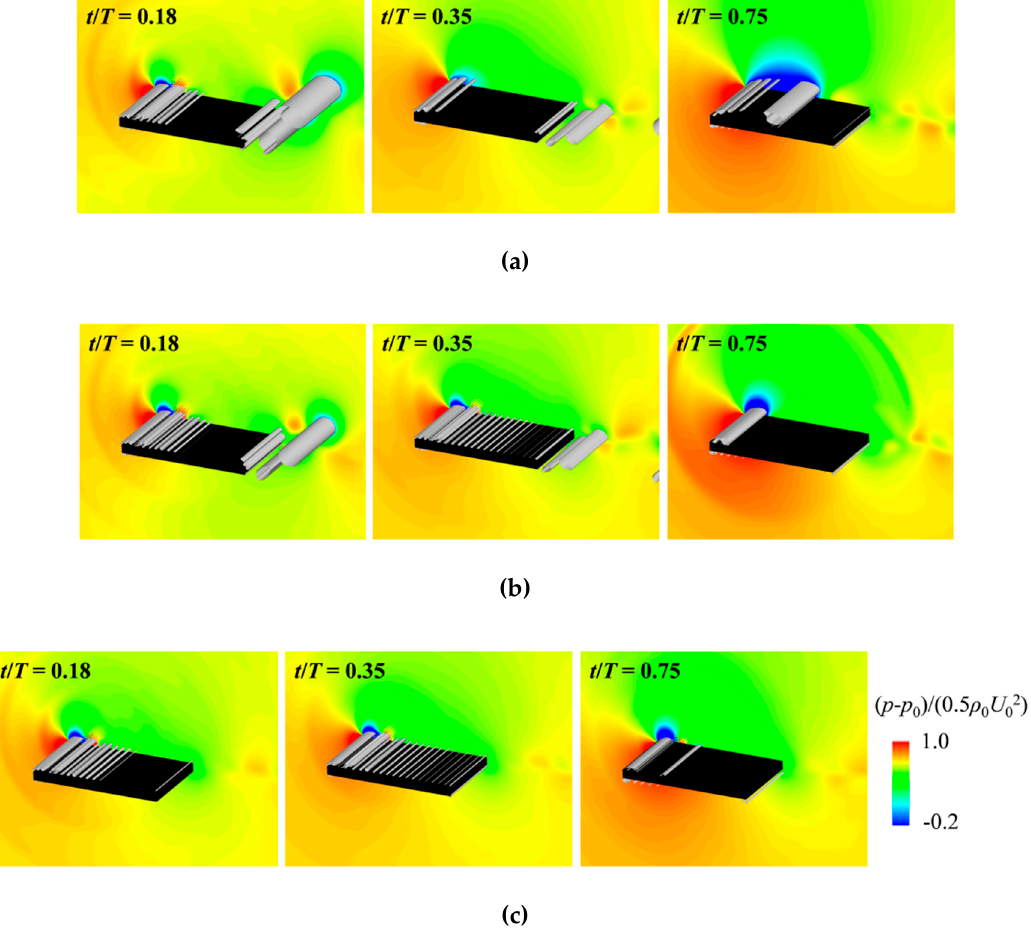
Figure 18. Iso-surfaces of second invariant ( q /( U 0 / b ) 2 = 0.1) of velocity gradient tensor and contours of pressure coefficient ( p - p 0 )/(0.5 ρ 0 U 02 ) around the oscillating plate for the control only on the top surface ( t 0 / T = 0.0), where p 0 is the ambient pressure. ( a ) Driving ratio of R = 25%; ( b ) R = 75%; ( c ) R = 100%.